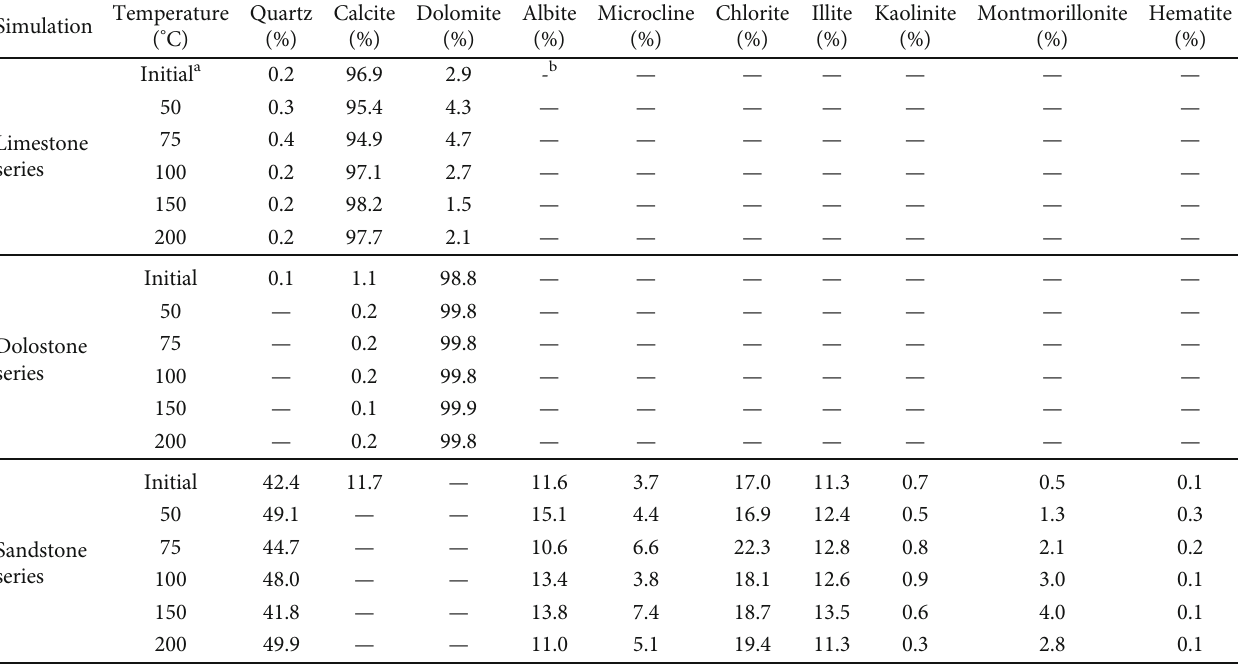
Figure 1: Location and images of the rock samples: (a) map of China showing the location of the Tarim and Sichuan basins; (b) structural map of Tarim Basin showing the location of well LN34 and Suohancun outcrop; (c) structural map of Sichuan Basin showing the location of Hejialiang outcrop; (d) hand specimen of micrite from the Ordovician Yingshan formation (O ) in well LN34 (5156 – 5165m below sea 1y level); (e) hand specimen of sucrosic dolostone from the Permian Qixia formation (P ) in the Hejialiang outcrop; and (f) hand specimen 1q of lithic arkose the Cretaceous Bashijiqike formation (K ) in the Suohancun outcrop. 1bs Table 1: Mineralogical compositions of initial and altered rock